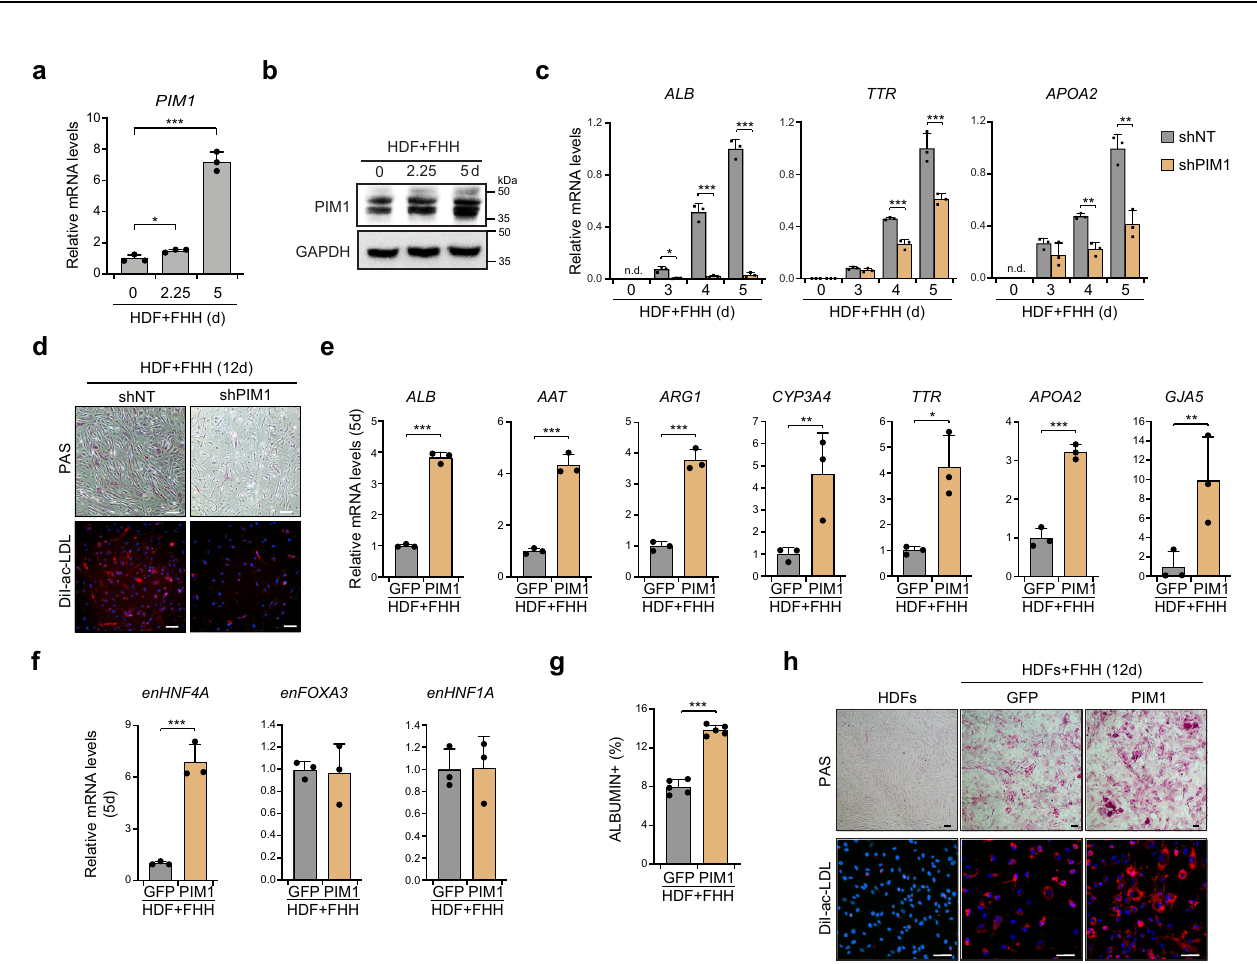
Fig. 4 | Experimental analysis of PIM1 roles in hepatic reprogramming. a Transcriptlevelsof PIM1 signi fi cantlyincreasedduringhepaticreprogrammingas quanti fi edbyRT-qPCR(2.25d p =0.0251,5d p <0.0001, n =3). b Immunoblottingof PIM1inHDFsinfectedwithFHHfortheindicatednumberofdays.GAPDHwasused asthereferenceprotein. n =3biologicalreplicates. c Expressionofhepaticgenesin HDFs infected with FHH and PIM1 shRNA as quanti fi ed by qRT-PCR ( n = 3). A n on- targeted shRNA (shNT) was used as the control. Knockdown of PIM1 showed sig- ni fi cantly decreased transcript levels of ALB (3d p = 0.0026, 4d p = 0.0002, 5d p <0.0001), TTR (4d p = 0.0009, 5d p = 0.0055), APOA2 (4d p = 0.0012, 5d p = 0.0028). d PASstainingandDiI-ac-LDLuptakeassayofHDFsinfectedwithFHHand either PIM1 shRNA or non-targeted shRNA for 12 days. Scale bars = 100 μ m. n = 3 biological replicates. Expression of hepatic functional genes ( e ) and endogenous